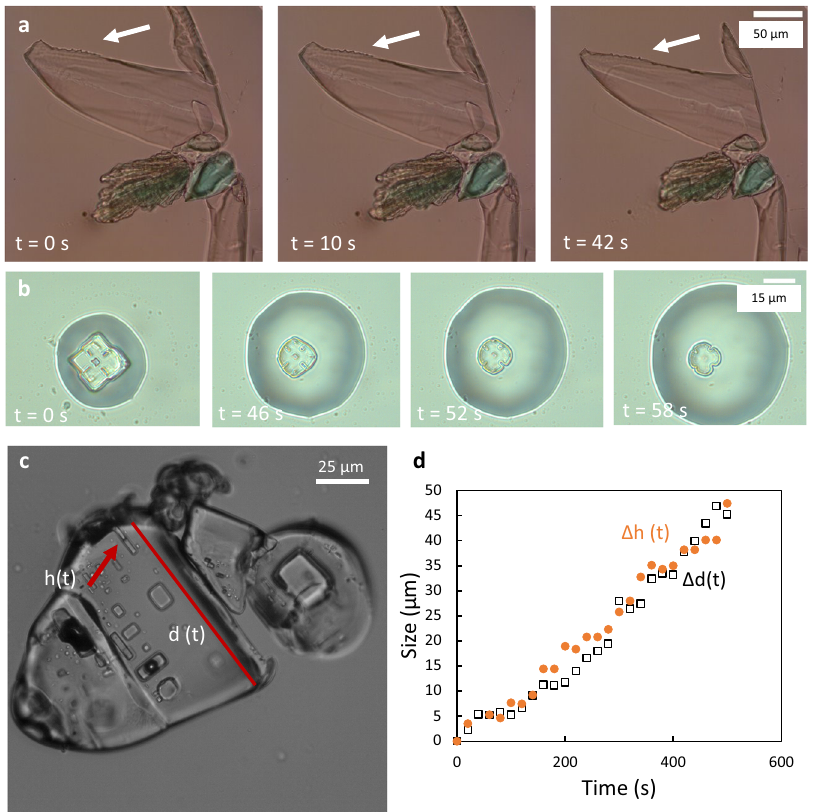
b Sodium chloride crystal, above deliquescence RH ≈ 75%. Surface defects keep their shape while the corners smoothen. c, d The decrease of the crystal size d(t) and the height of the defect h(t) at the surface (red arrow) follow the same